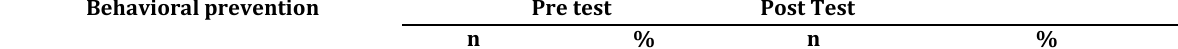
Table 1. Pretest and posttest results for behavioral prevention (n=57) Behavioral prevention Pre test